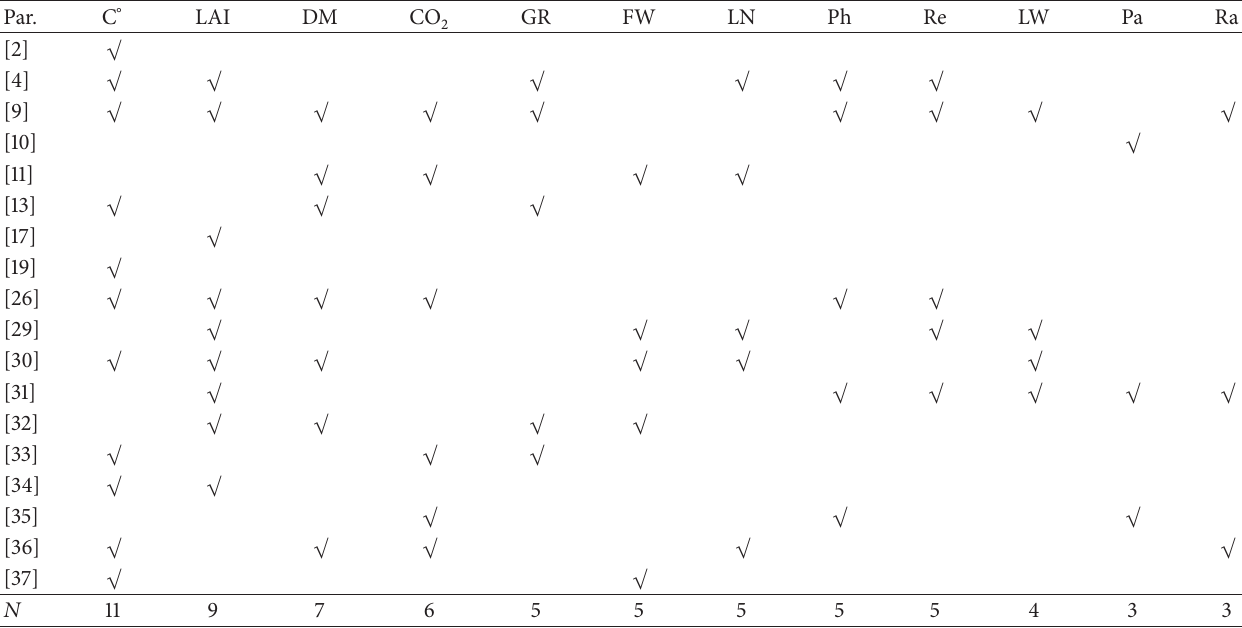
Table 1: Parameters used in published